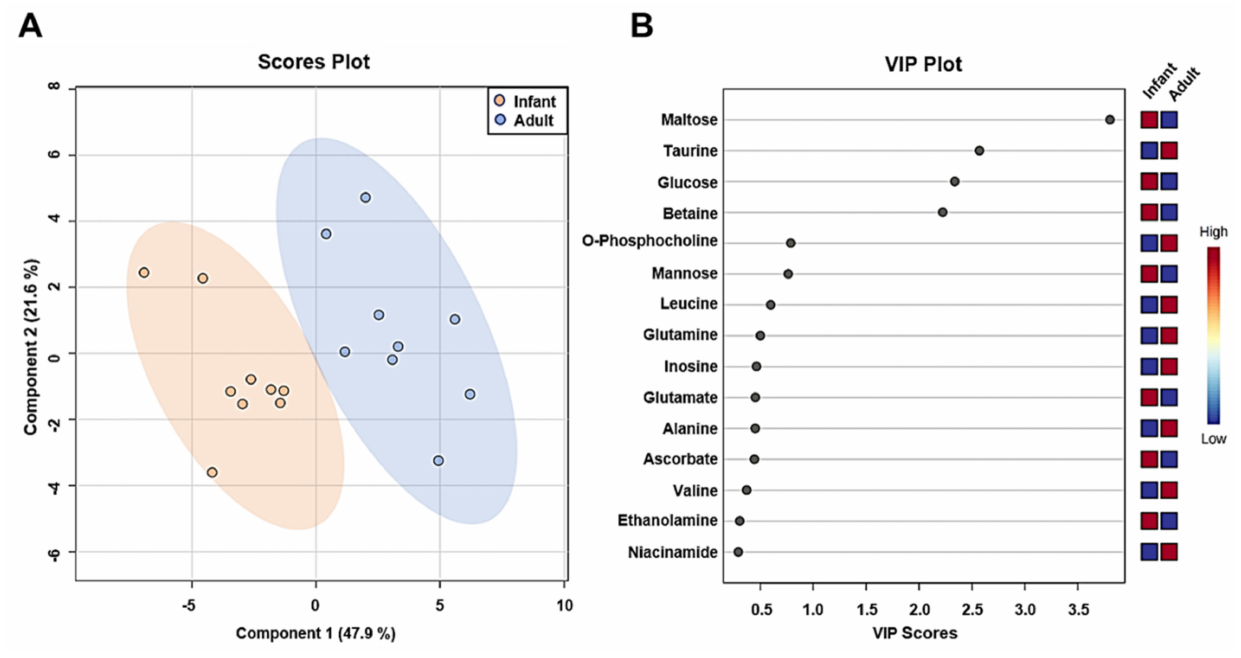
Figure 5. PLS − DA and VIP score plots. ( A ) PLS − DA score plot comparing infant (3 − week − old, n = 9) and adult (9 − week − old, n = 9) male mice groups. ( B ) The variable importance in projection (VIP) score plot from PLS − DA analysis of important metabolites from infant and adult